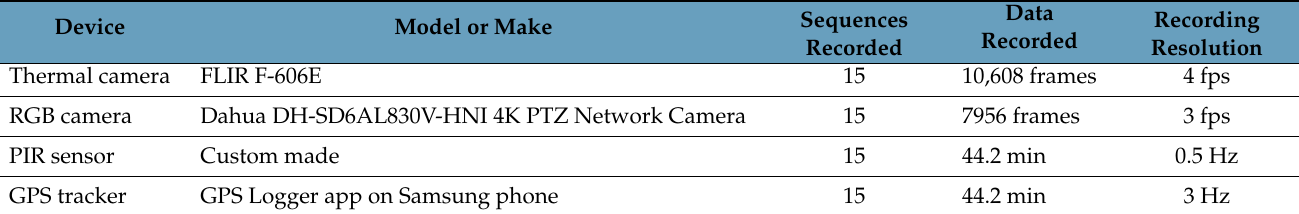
Table 1. Dataset specifications.